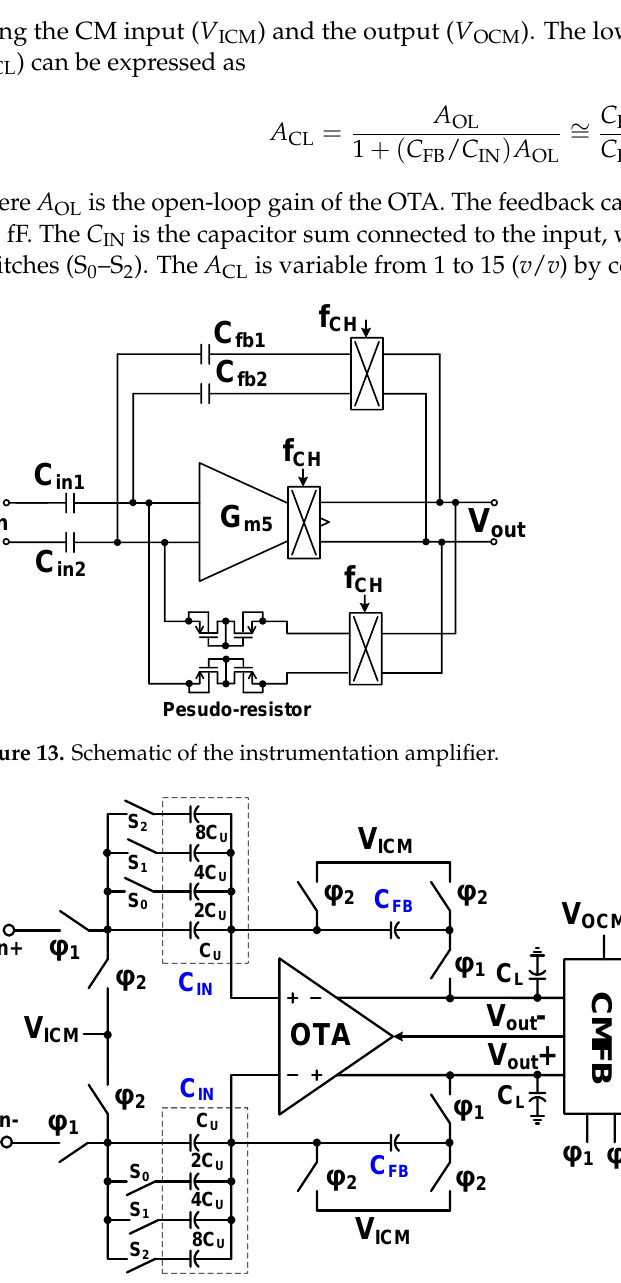
Figure 14. Schematic of the PGA.